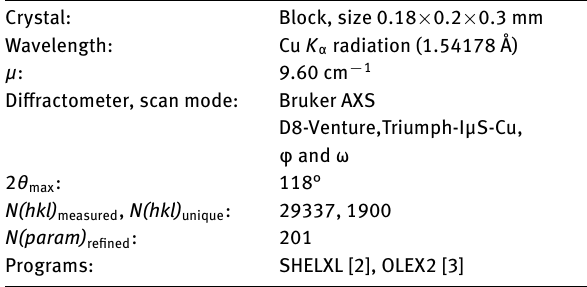
Table 2: Fractional atomic coordinates and isotropic or